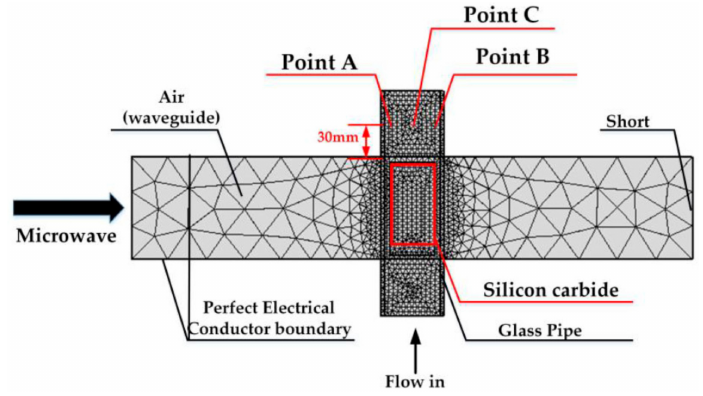
Figure 9. Identification of different temperature measurement